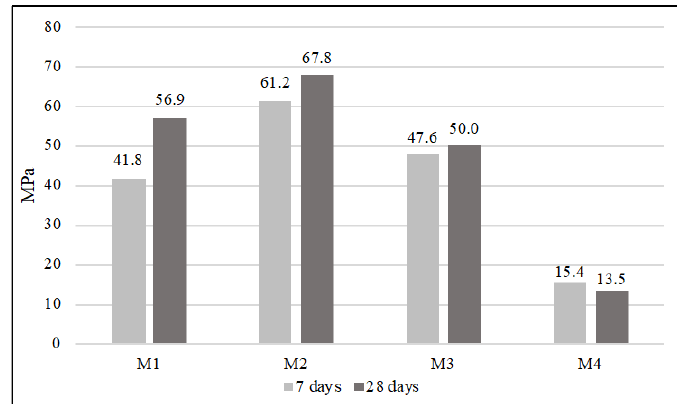
Figure 4. Compressive